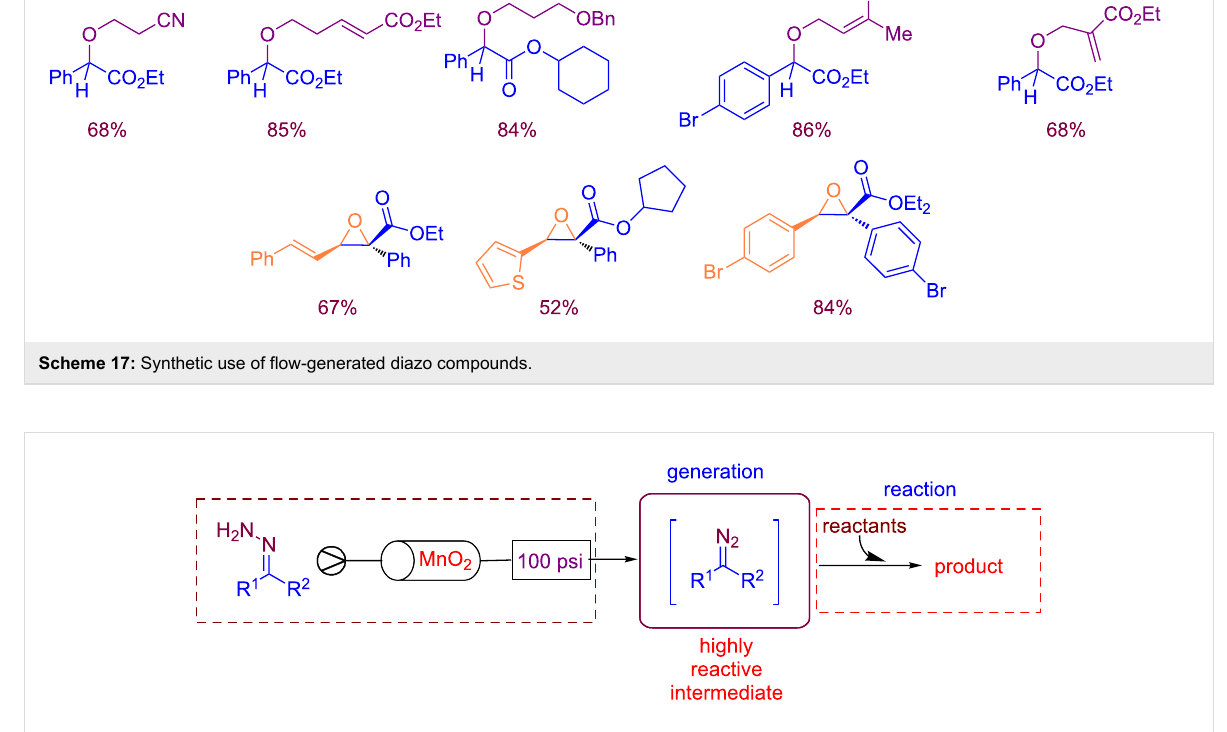
Scheme 18: Ley’s flow approach for the generation of diazo